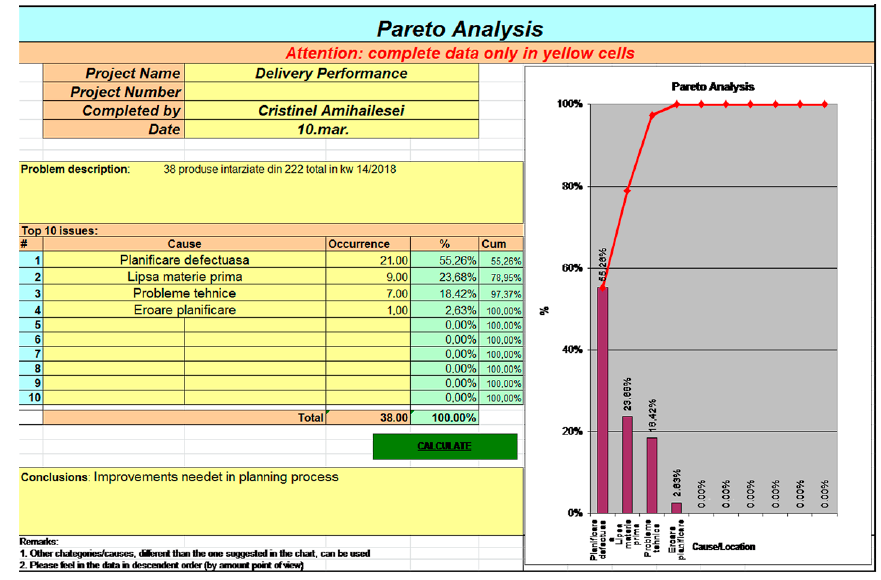
Figure 6. Analysis of the causes of the delay of the product’s parts